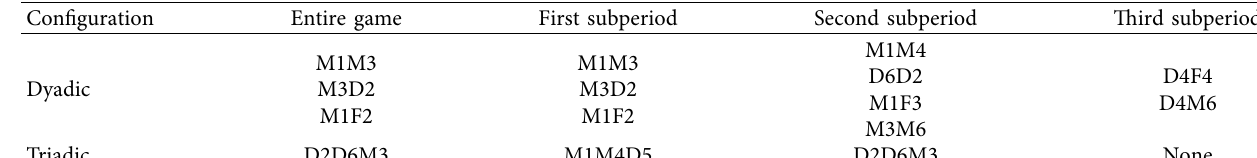
Figure 9: Three subperiod passing networks. Table 5: Dyadic and triadic configuration during different period.